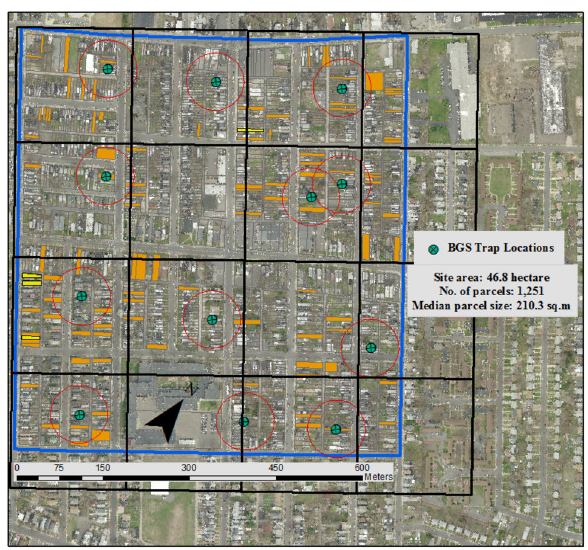
Figure 1. Aerial map of the study site and 12 BGS trapping sites within a 50 m radius (red circles/sampling units). We aimed to place each BGS trap within one of the cells of a square grid with 200 m sides. When that was not possible we placed the BGS trap in a nearby cell. Orange highlighted parcels indicate parcels with at least one container positive for immature Ae. albopictus during the month of August 2009. The four parcels highlighted in yellow were the only ones never inspected during the